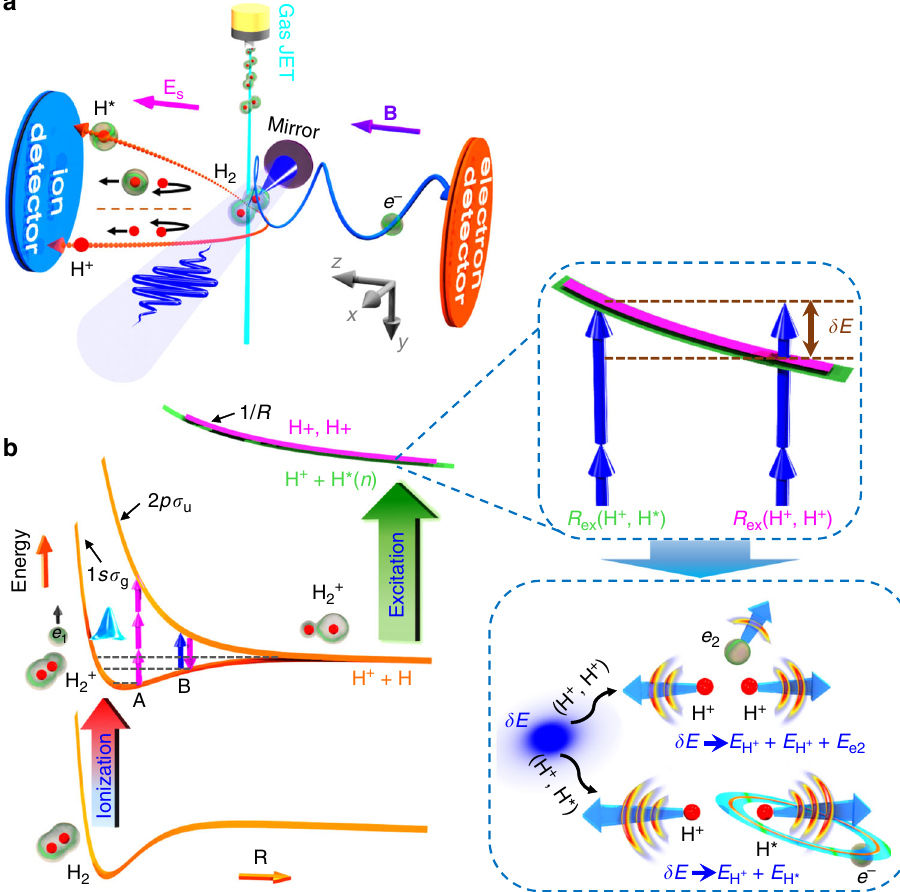
Fig. 1 Rydberg excitation in strong- fi eld breaking of a H 2 molecule. a Schematic illustration of the experimental setup. A linearly polarized (along z -axis) UV laser pulse is focused onto a supersonic gas jet of H 2 molecules by using a concave silver mirror inside an ultrahigh vacuum chamber of the COLd Target Recoil Ion Momentum Spectroscopy (COLTRIMS) apparatus. The laser-created charged (H + and freed electron) and neutral particles (H * ) are detected by two time-sensitive and position-sensitive detectors in coincidence. Here E s and B are the electric and magnetic fi elds of the spectrometer. b The fi eld-free potential energy curves showing the three-step process for generating the (H + , H + ) or (H + , H * ) channels in the strong- fi eld breaking of H 2 molecules. After the single ionization of neutral H 2, the ionization-created nuclear wave packet will stretch in the laser fi eld via different photon-resolved pathways. The excitation of the stretching H 2 + towards (H + , H + ) or (H + , H * ) occurs at slightly different internuclear distances. By resonantly transferring the molecular ion onto the repulsive Rydberg states of H 2 + at a smaller internuclear distance R ð , the outgoing nuclear fragments gain a larger kinetic H þ ; H ? Þ energy than those of the (H + , H + ) channel for which the excess photon energy δ E above the ionization threshold is taken by the freed